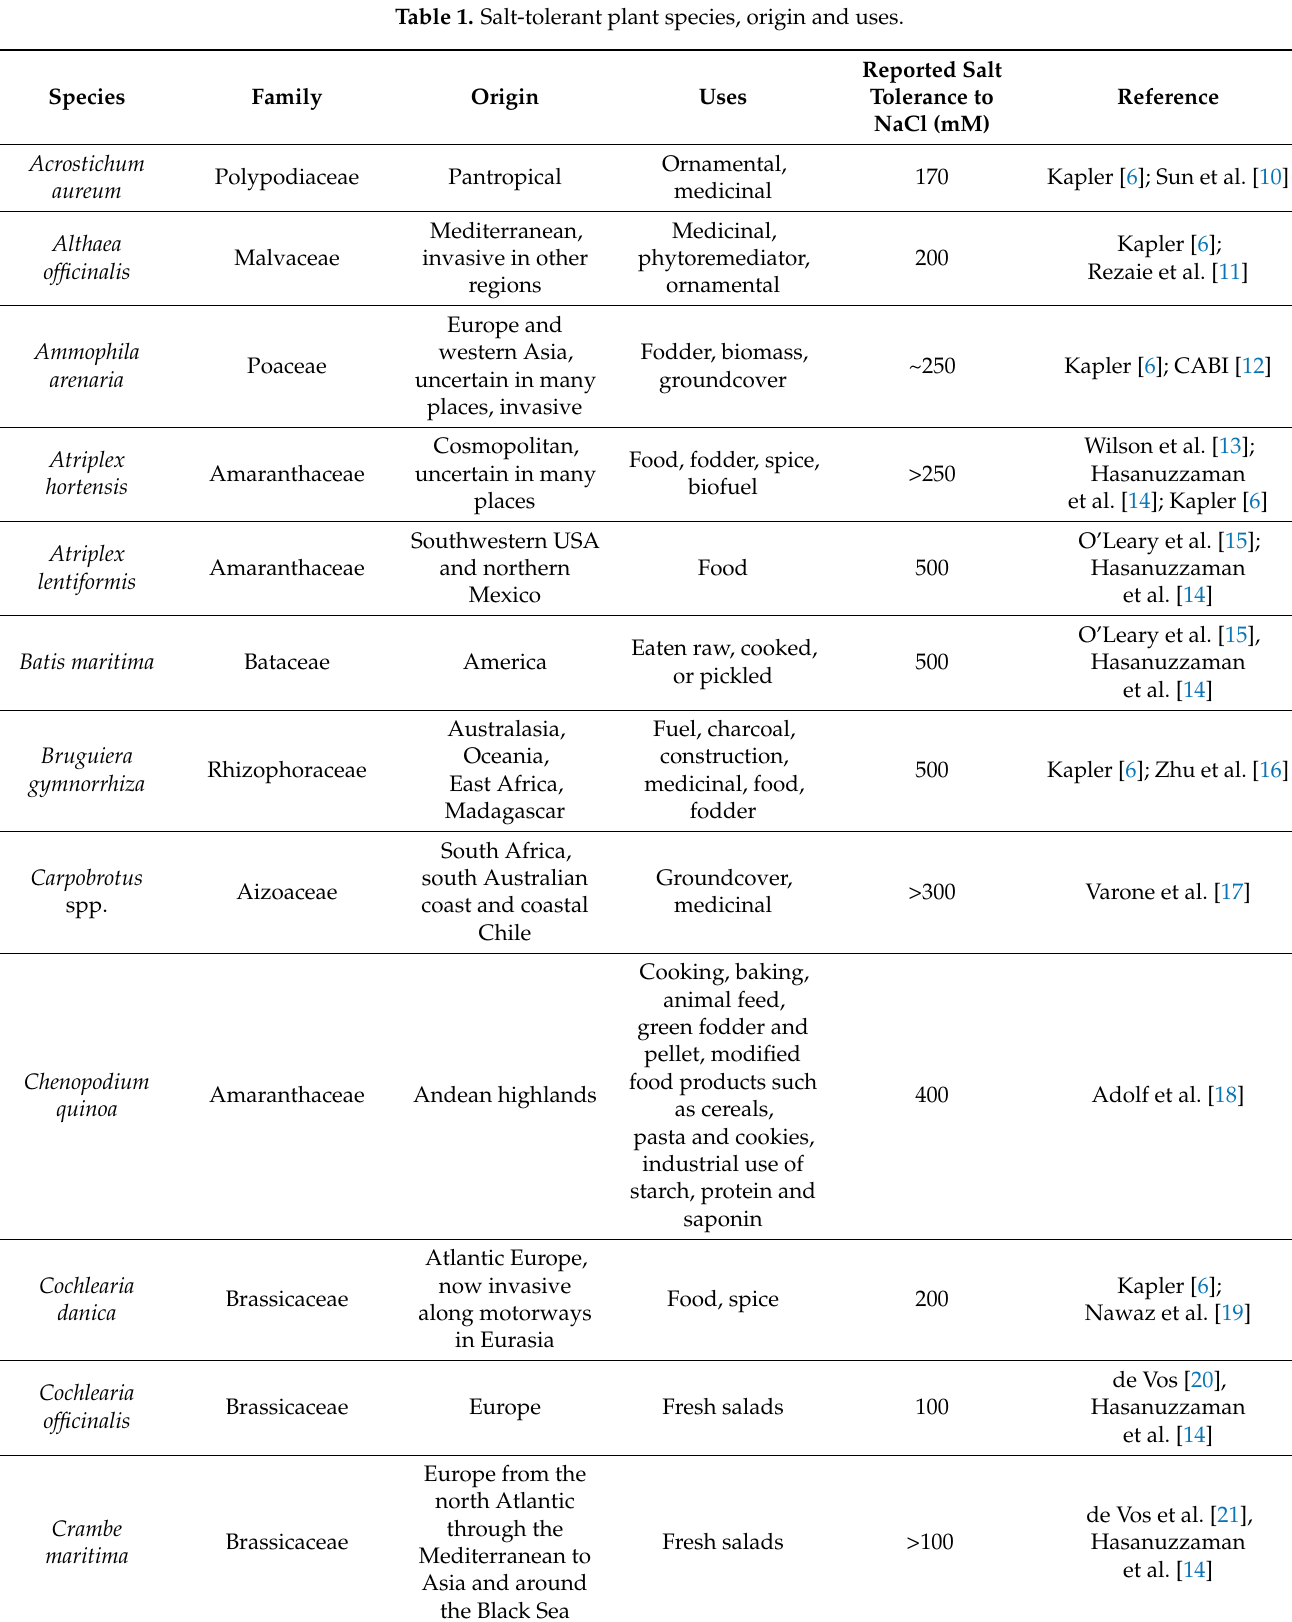
Table 1. Salt-tolerant plant species, origin and